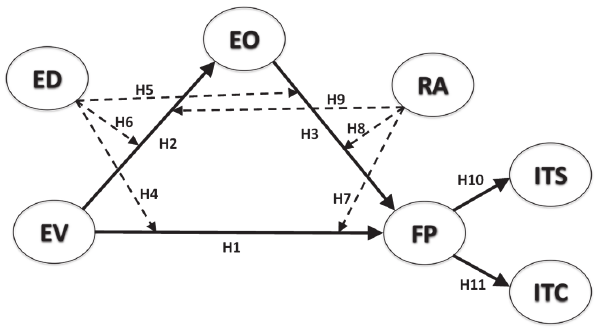
Fig. 1. The Conceptual